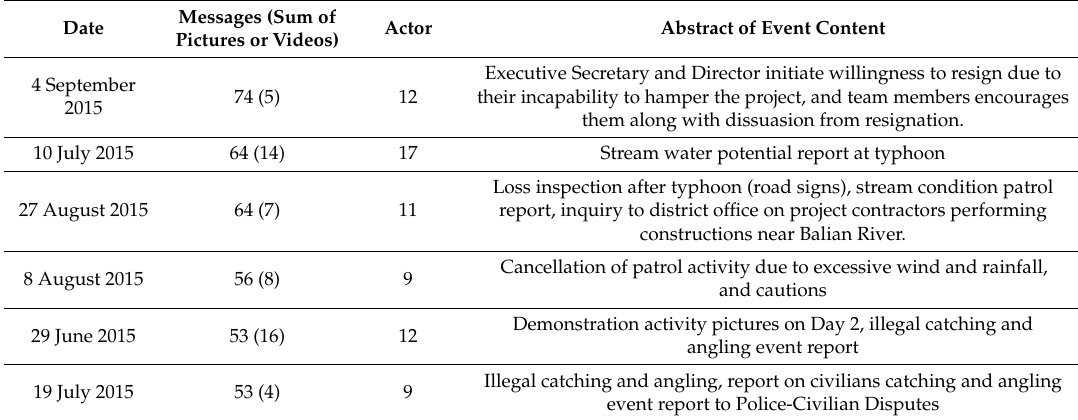
Table 5. Chronicle of activities and